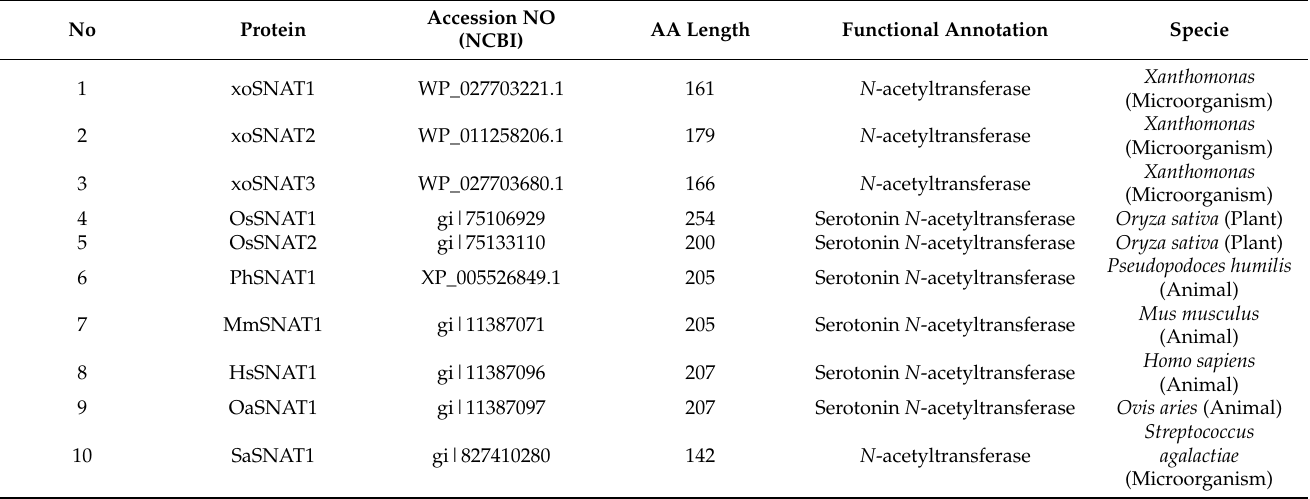
Table 1. List of ten full-length proteins information for GCN5-related N - acetyltransferases